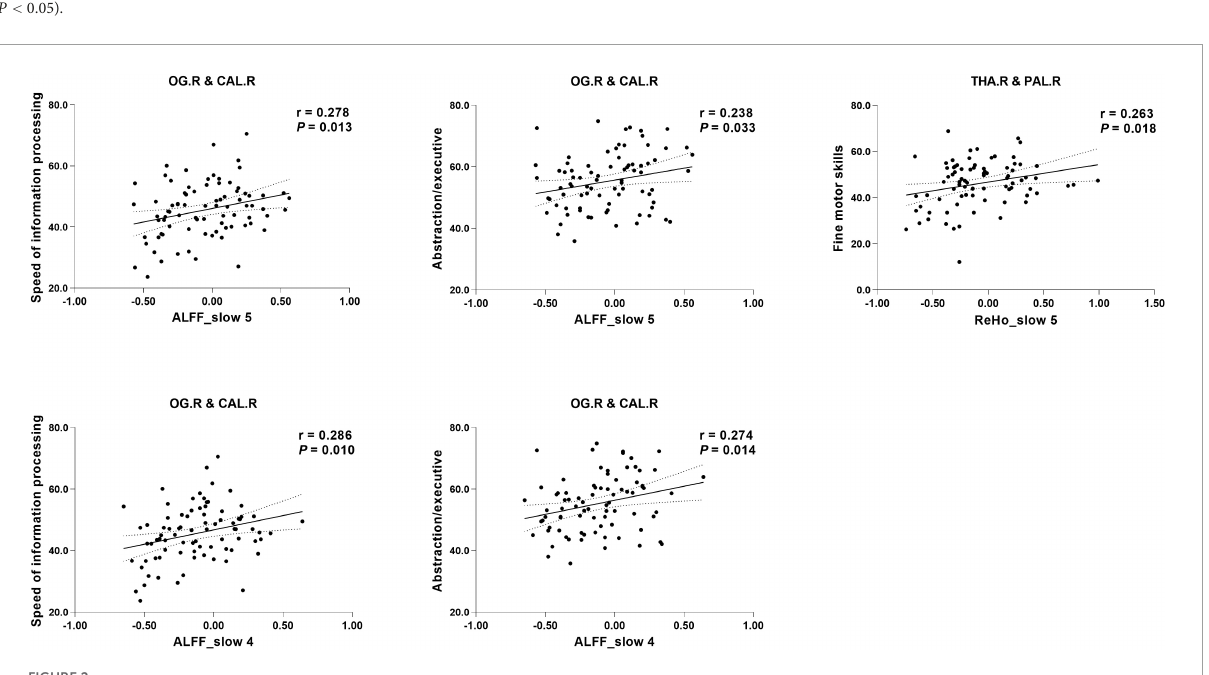
FIGURE2 Correlation between specific cognitive domains and imaging indices. The areas between two dotted curves indicate the 95% confidence interval. THA.R, right thalamus; PAL.R, right globus pallidus; PCUN, precuneus; PCL, paracentral